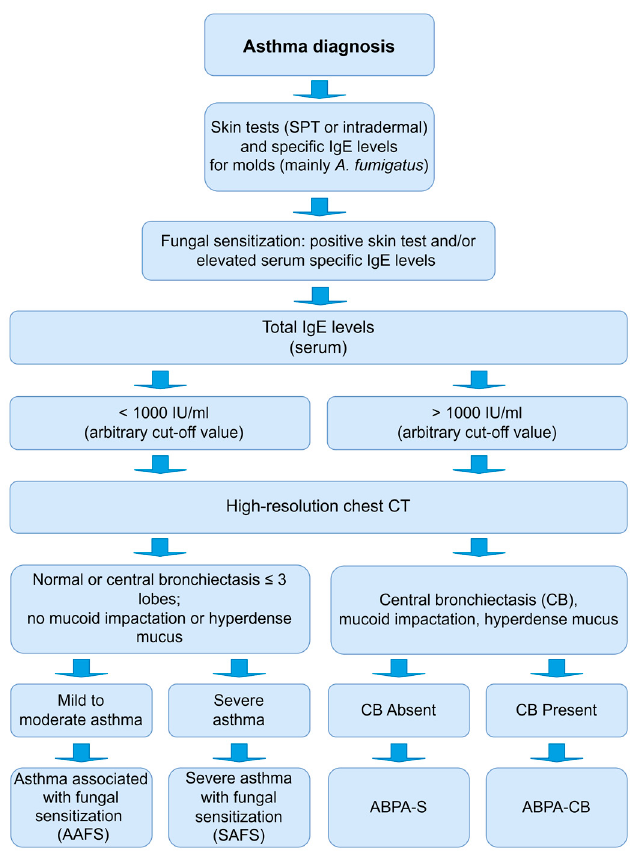
Figure 1. Diagnostic algorithm for SAFS versus ABPA (modi fi ed from [47]).